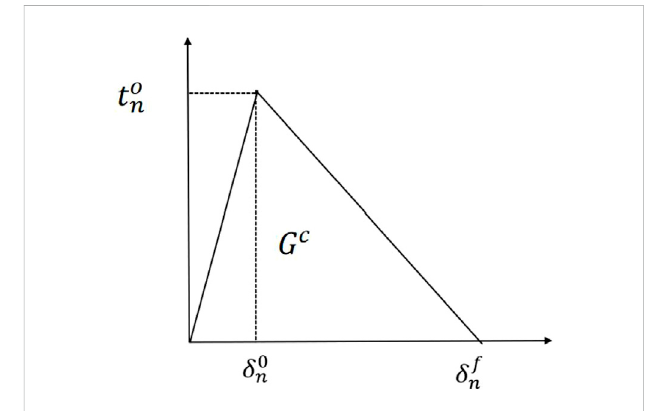
FIGURE 1 Typical traction — separation constitutive